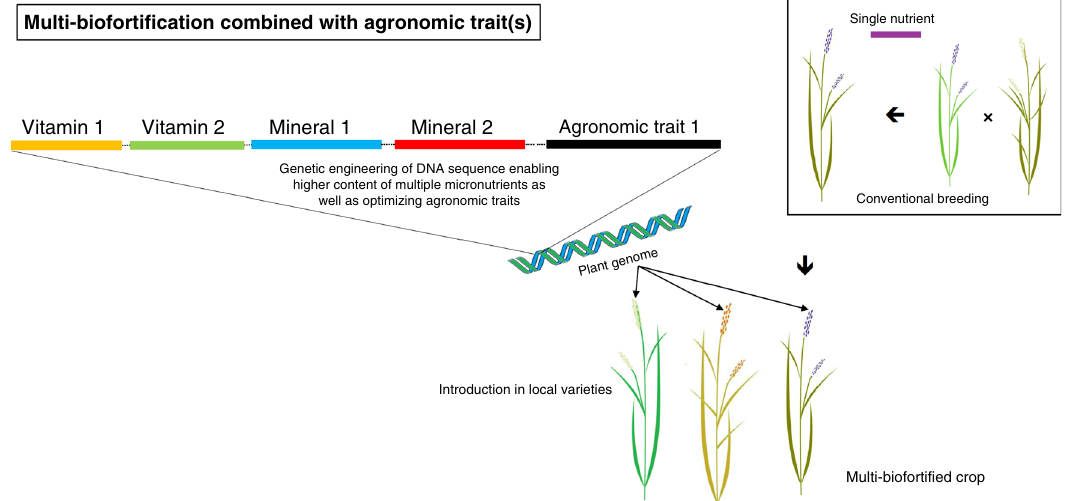
Fig. 1 Multi-bioforti fi cation in combination with agronomic traits. Genetic engineering enables creation of a single DNA cassette, harboring information to allow increase in multiple micronutrients (vitamins and/or minerals) as well as favorable agronomic traits, possibly in combination with (conventional) breeding. The cassette can be targeted to a speci fi c genomic location in multiple local cultivars of a crop plant of interest, e.g.